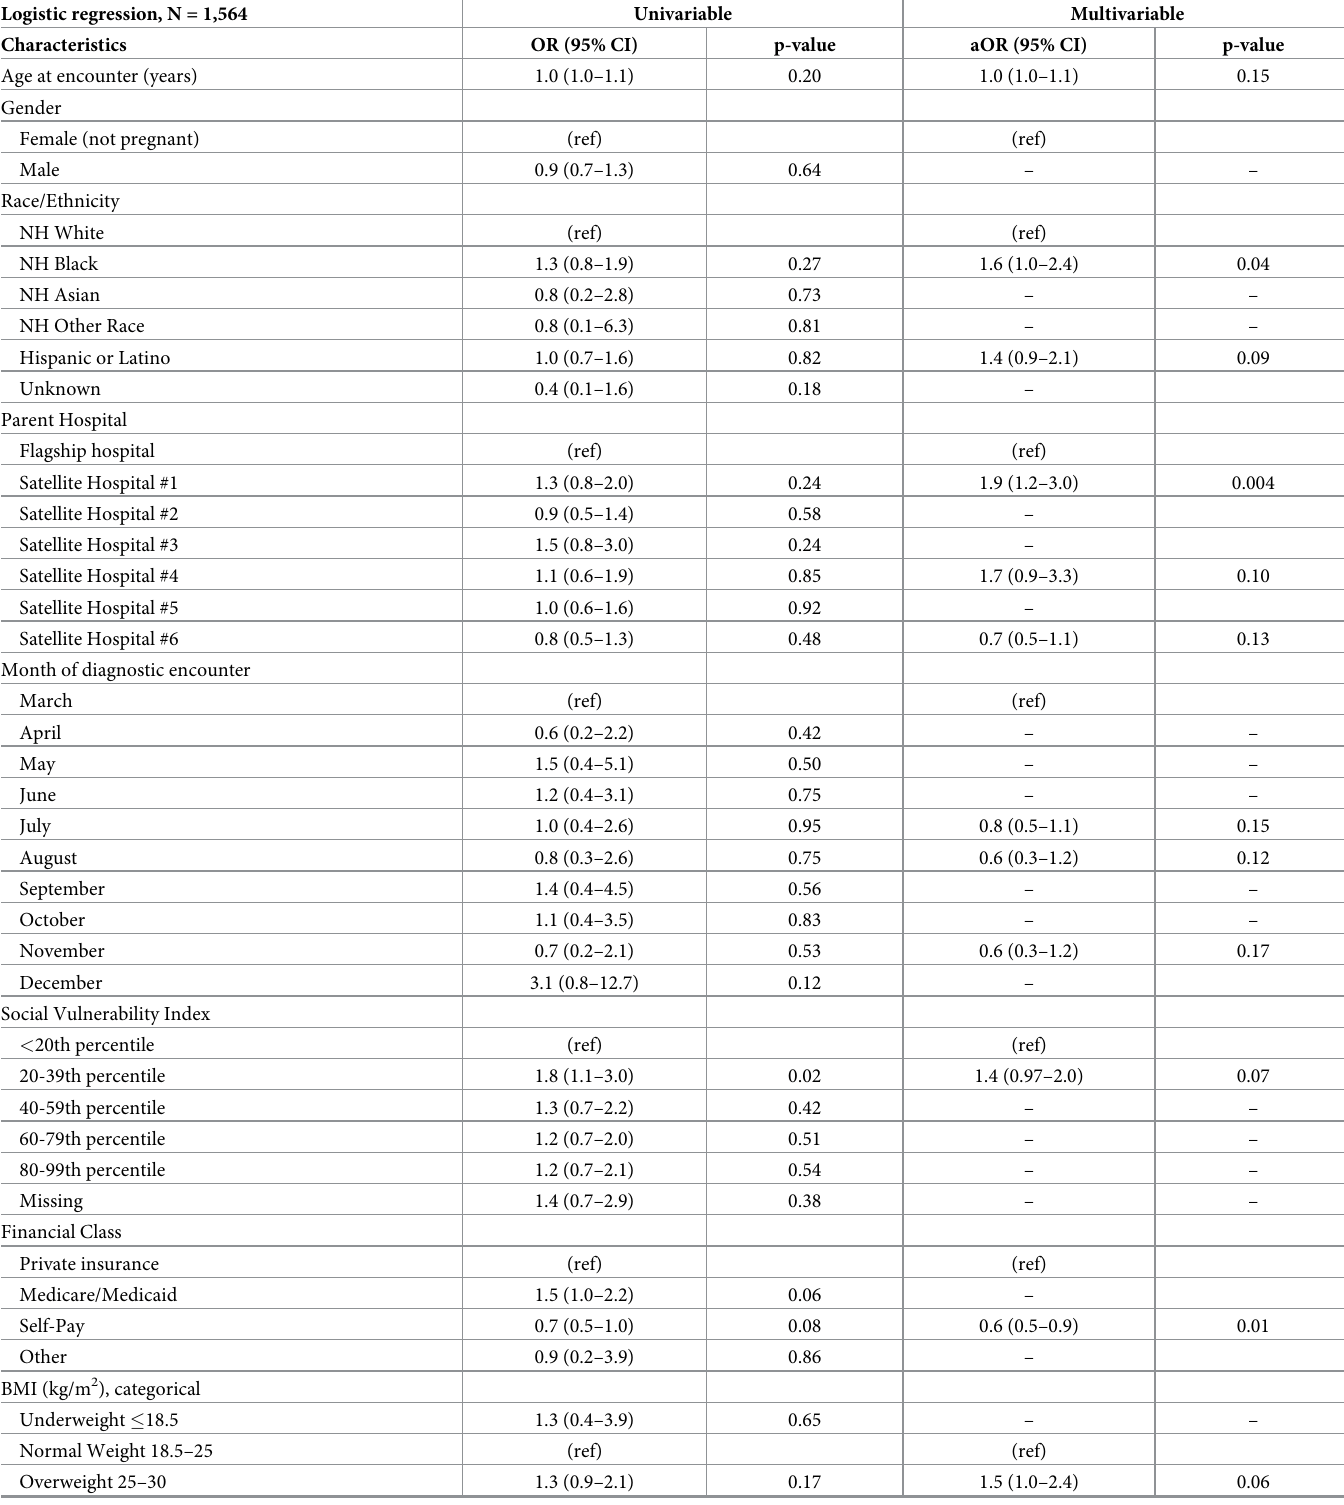
Table 6. Risk factors for subsequent hospital encounter within 30 days among non-pregnant COVID-19 patients 18–29 years, diagnosed at a hospital